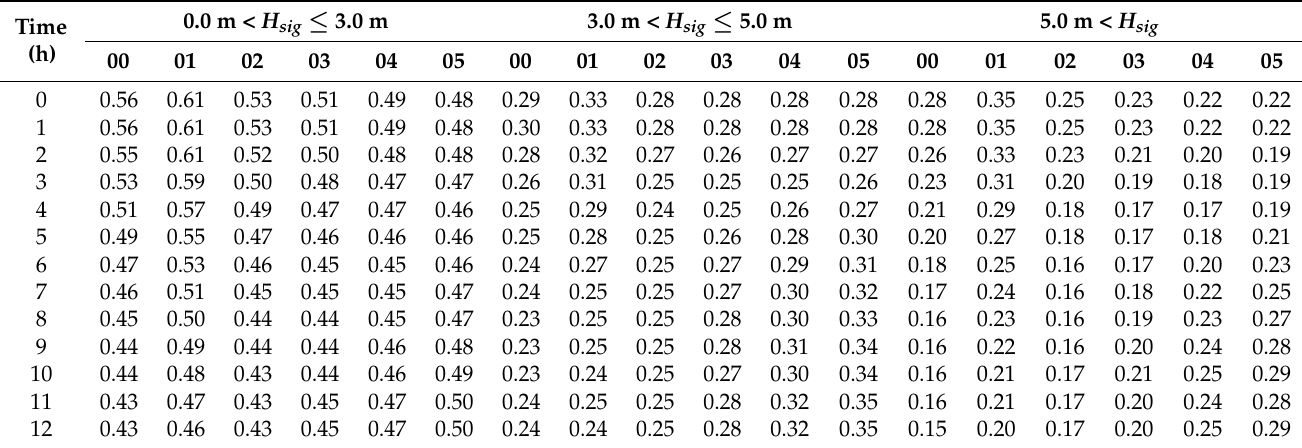
Table 3. Averaged root mean square error (RMSE) of the threshold significant wave height for each forecast lead time. 0.0 m < H sig ≤ 3.0 Time (h)